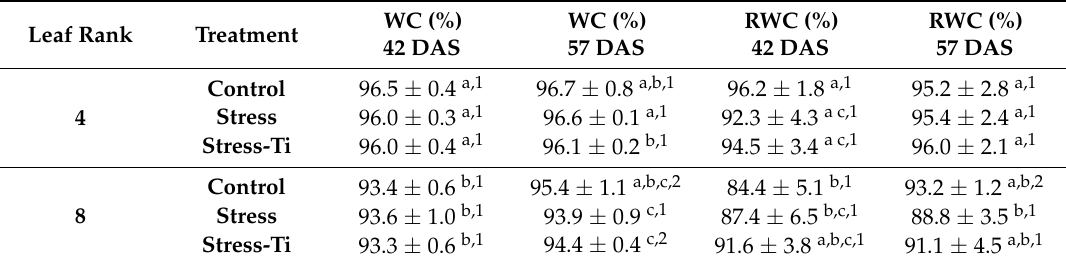
Table 1. Water Content (WC) and Relative Water Content (RWC) of LR 4 and LR 8 at two stages (42 and 57 days after sowing (DAS)) and for different treatments. Different letters means statistical differences ( p < 0.05) between treatments or leaf ranks and different numbers means statistical differences ( p < 0.05) between stages for the same leaf.